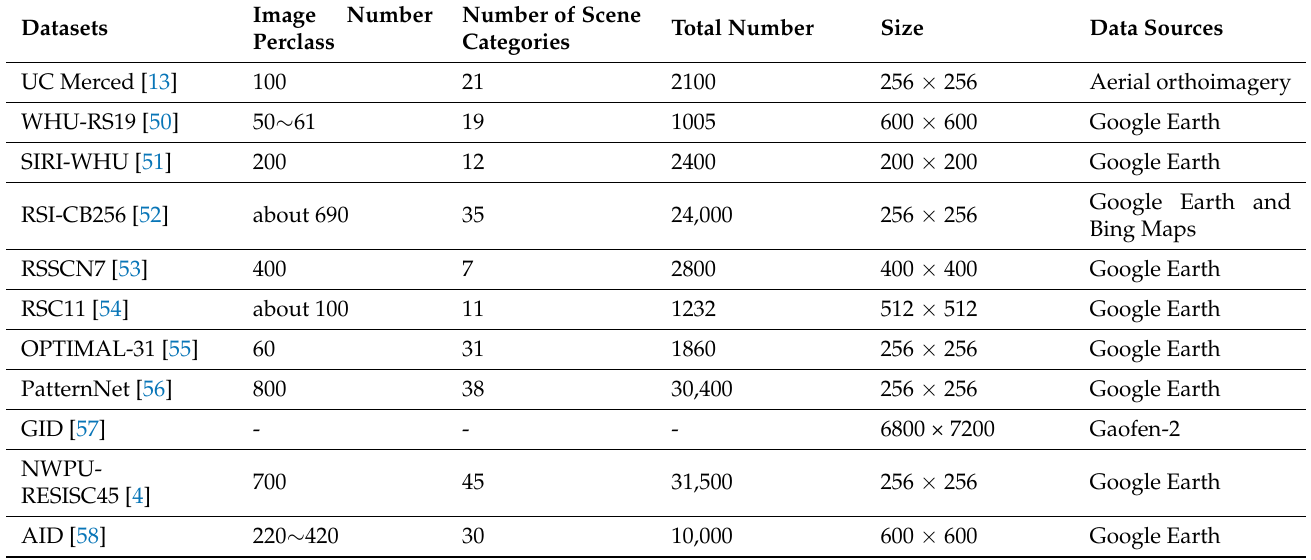
Table 1. The experiment